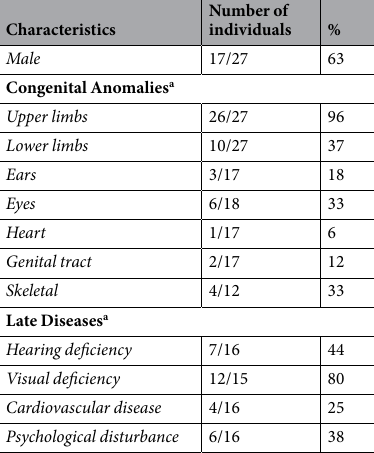
Table 2. Clinical characterization of individuals with Thalidomide Embryopathy. a Data not available for all 27 individuals of the TE